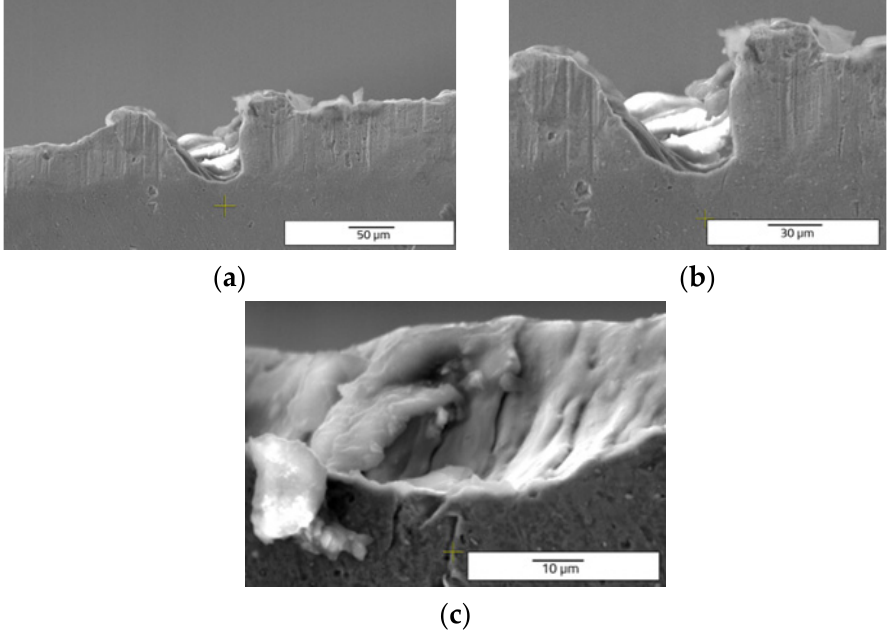
Figure 6. Cross section SEM images of octagonal donuts shape (design type A) of LST, frequency 30 kHz, speed 300 mm/s, and no. of repetitions 10, magnification overview of the textured groove ( a ), magnification of the LST processed region ( b ), magnification of the hollow ( c ).